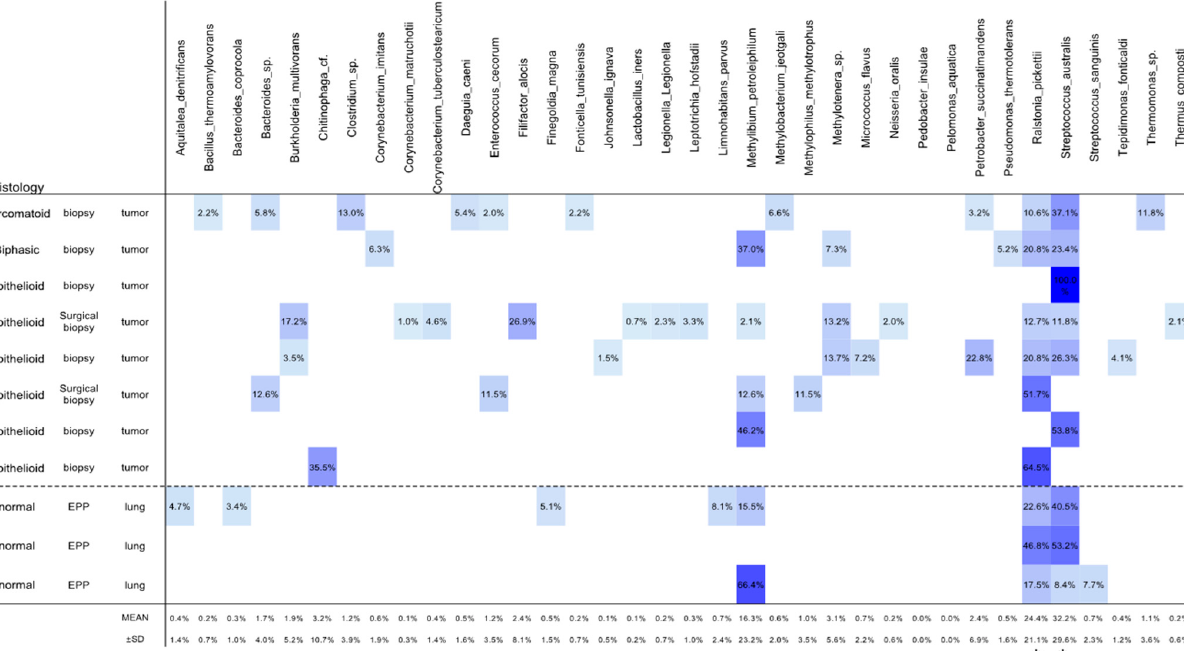
Figure 1. Composition and abundance of dominant species in all the samples. Heatmap visualizes the abundance of detected species. *, p < 0.05, compared with the other species except Methylibium petroleiphilum